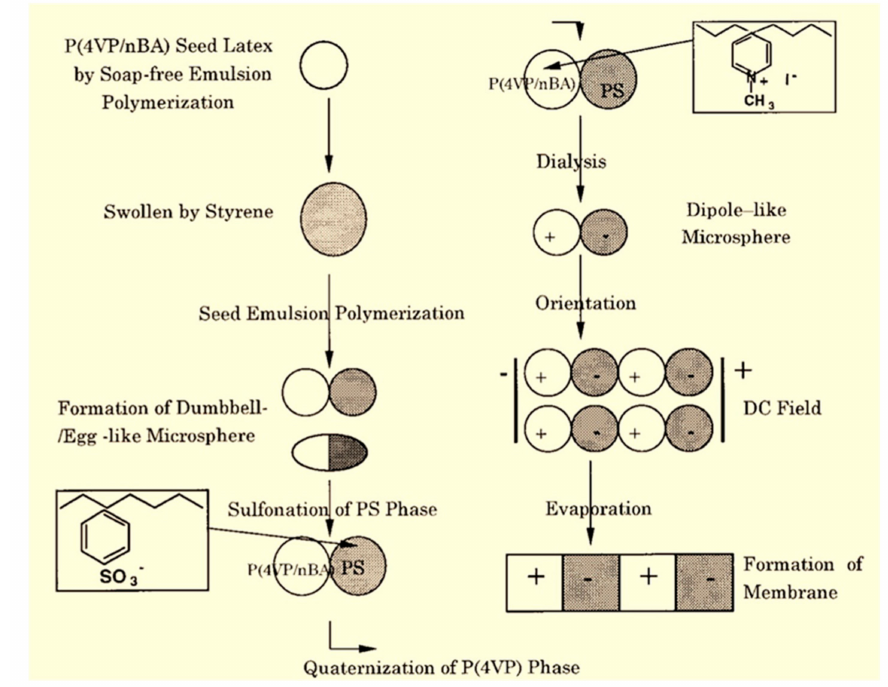
Figure 22. The schematic process of the preparation of a charged mosaic membrane by employing dipole dumbbell- and egg-like microspheres. Reproduced with permission from Reference